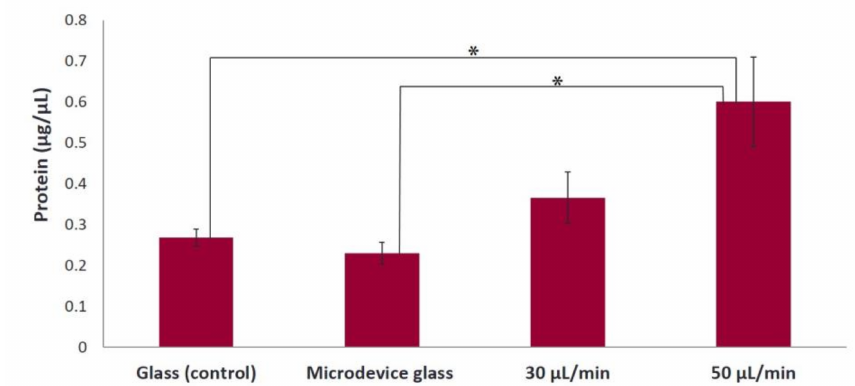
Figure 8. Amount of cells expressed as total protein concentration after 7 days of culture on fibrous collagen substrates under static (glass and microdevice glass) and flow conditions (flow rates of 30 and 50 µ L/min). A * p value of < 0.05 was considered significant.